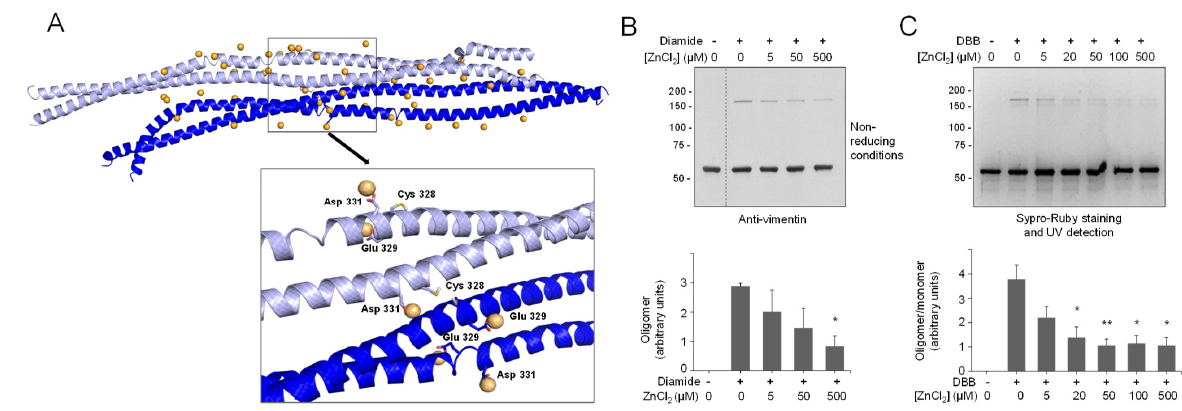
Figure 5. Interaction of zinc with the vimentin nearby-CYS vimentin tetrameric association and effect on cysteine cross- linking. ( A ) Zinc atoms remaining in the proximity of the vimentin nearby-CYS tetrameric association, with Cys328 in its thiol form, are shown after 30 ns of MD simulation. Details of zinc interactions with residues in the vicinity of Cys328 are depicted in the enlarged image. ( B , C ) Effect of zinc on vimentin cysteine crosslinking. Vimentin wt (4.3 μ M final concen- tration) was incubated in the presence of increasing concentrations of ZnCl 2 for 1 h at r.t before induction of cysteine crosslinking by oxidation with 1 mM diamide ( B ) or chemical crosslinking with 24 μ M DBB ( C ), for an additional hour. Incubation mixtures were analyzed by non-reducing SDS-PAGE followed by western blot with anti-vimentin ( B ) or by SDS-PAGE followed by Sypro Ruby staining and UV detection ( C ). The ratios of oligomeric vs. monomeric species are depicted in the graphs as average values ± SEM from three assays. * p < 0.05 vs. diamide or DBB in the absence of ZnCl 2 ; ** p < 0.001 vs. DBB in the absence of ZnCl 2 , by unpaired Student’s t -test.